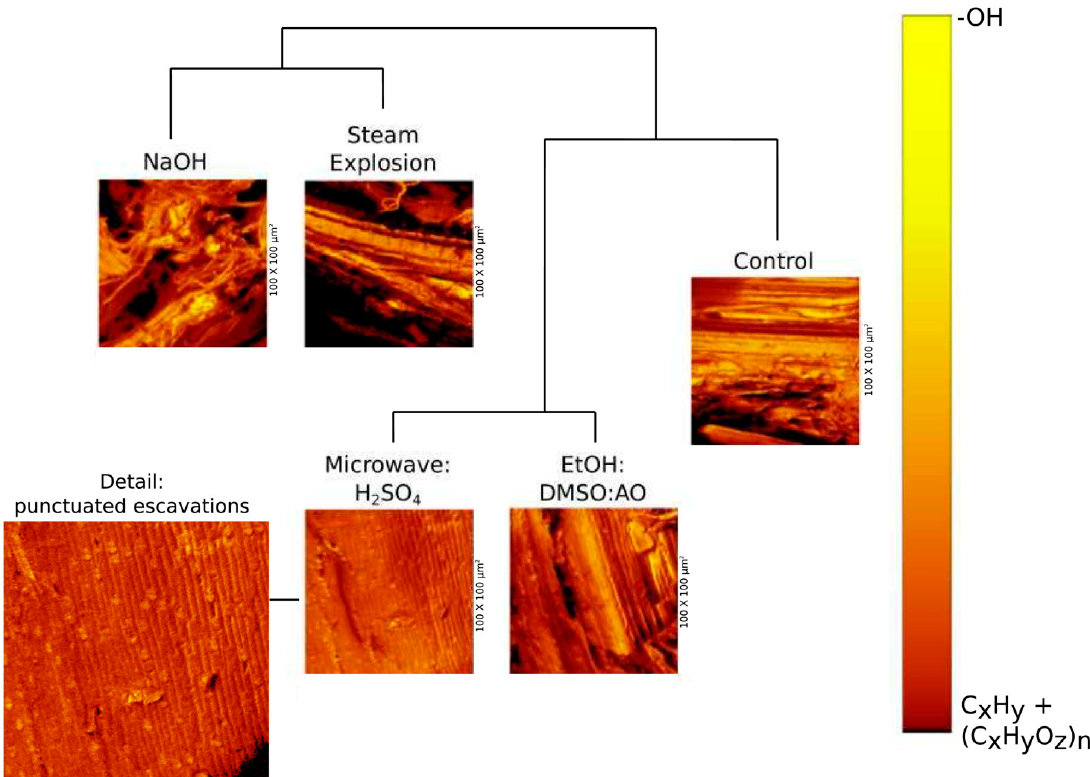
Figure 1. The overlapped signals of aromatics, (C x H y O z ) n residues and C x H y chains generated from